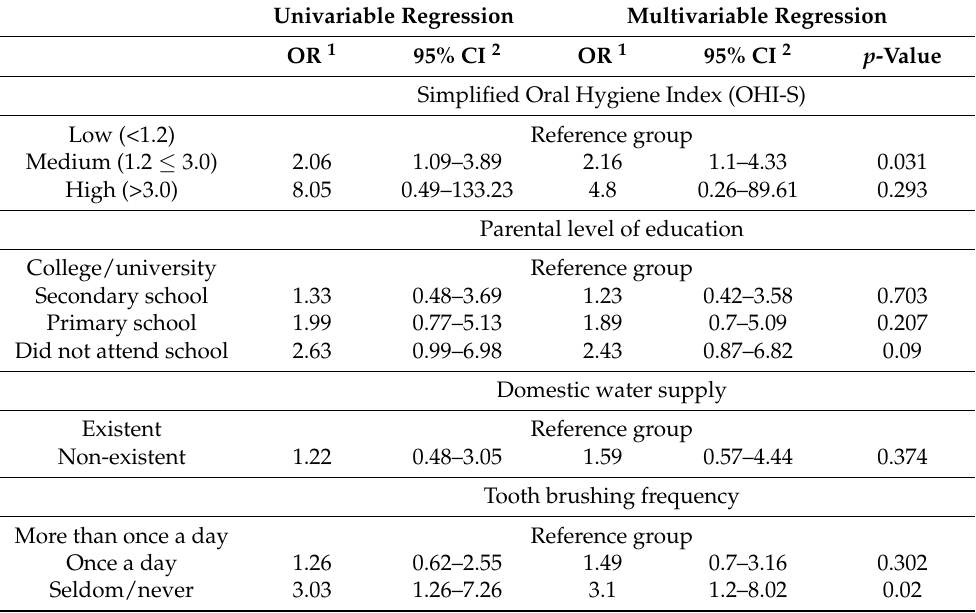
Table 7. Logistic regression to assess the predictive influence of different variables on caries risk. Univariable